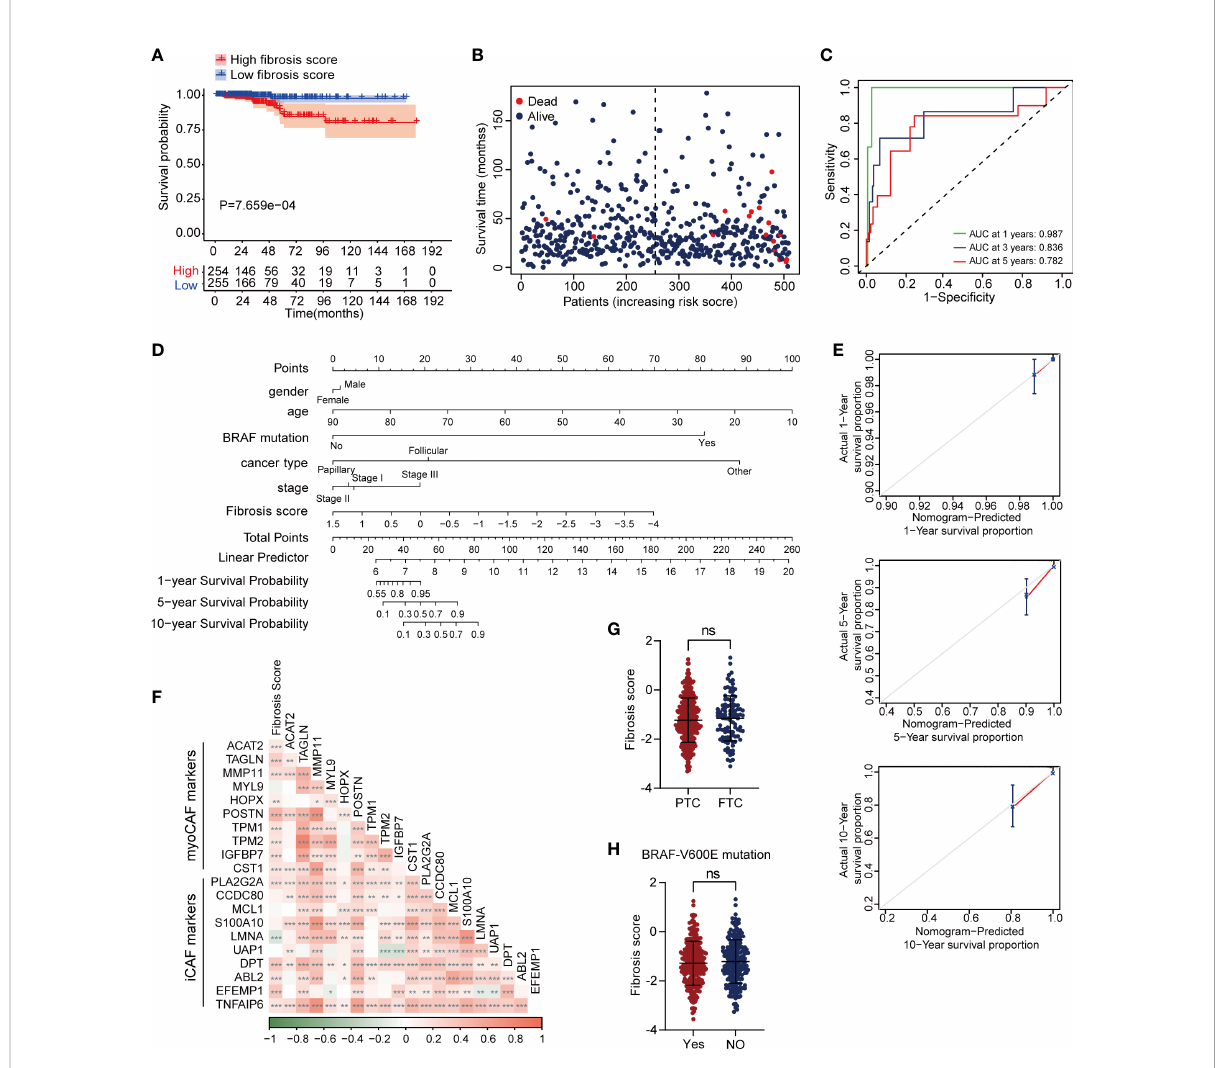
(C) The time dependent ROC plot of fi brosis score. (D) A nomogram plot for survival predication in thyroid cancer patients. (E) The calibration curve of nomogram showed optimal prognosis predicating ef fi ciency. (F) The correlation between fi brosis score and marker genes of myoCAF and iCAF. Fibrosis score showed no signi fi cant difference between PTC and follictalar thyroid carcinoma (FTC) (G) , as well as BRAF-V600E mutation (H) . *P < 0.05; **P < 0.01; ***P <